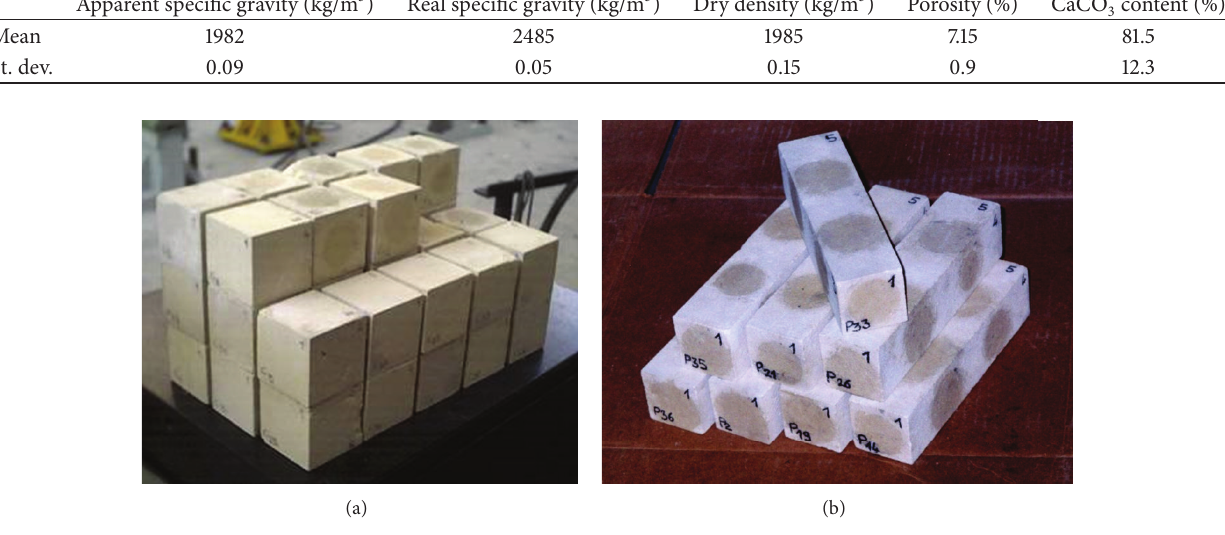
Figure 1: Cubic and prismatic limestone specimens.